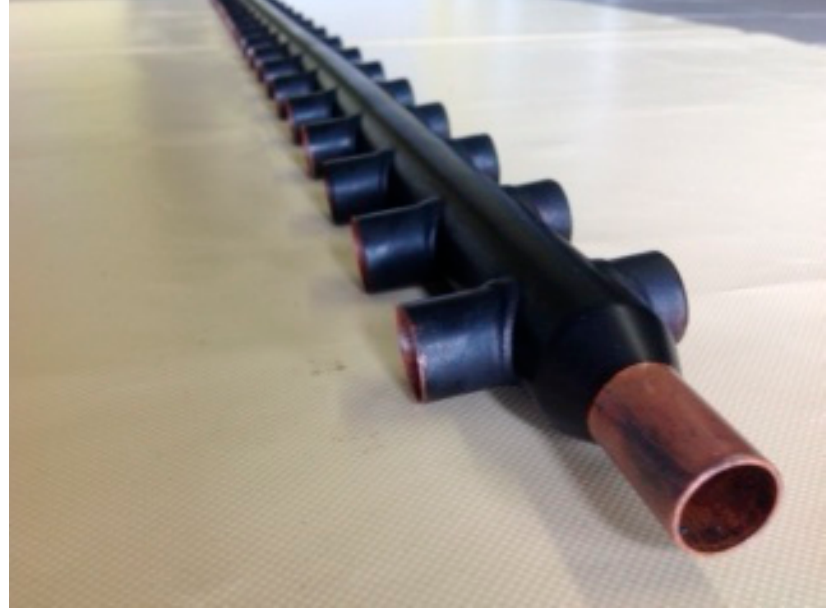
Figure 12. A manifold with an applied coating of a known emissivity factor ε m.